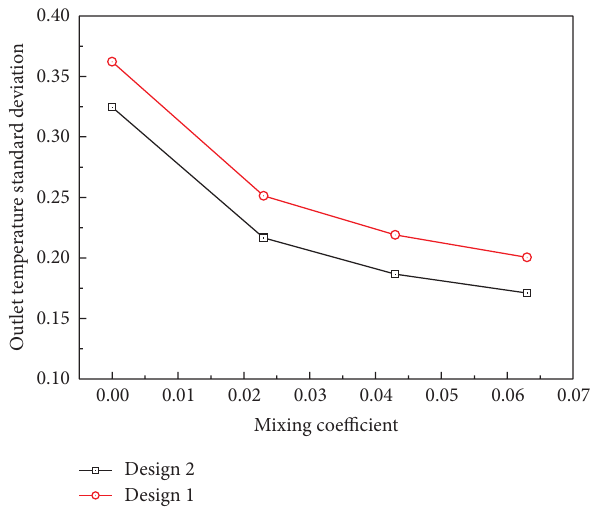
Figure 10: Outlet temperature standard deviation variation as mixing coefficient.